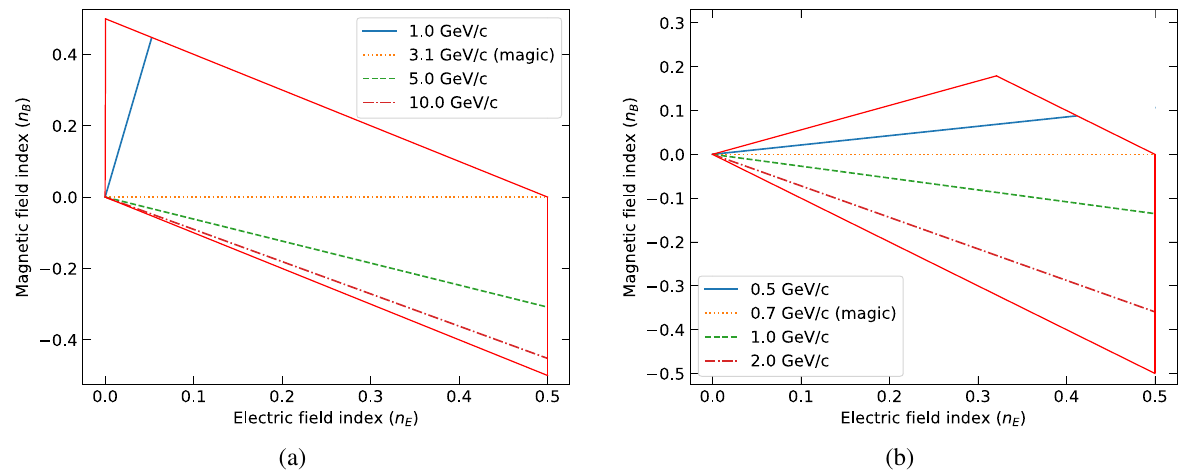
FIG. 6. The relation between the magnetic and electric field indices ( n and n ) to cancel out the dispersion correction for given B E momenta of the muon and the proton. The field indices must lie within a region enclosed by the red solid lines, to obtain the net vertical focusing and positive momentum. The magic momentum case for each particle is shown for validation, where it needs only the electric 0 ). (a) Muon. (b) Proton. focusing to be present ( n B ¼